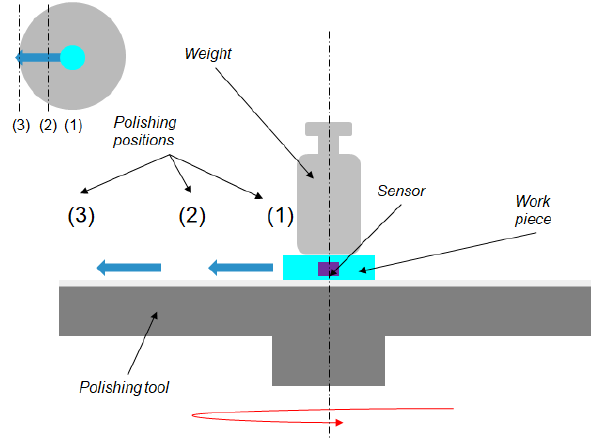
Figure 2: Arrangement of the experiment. The polishing at various points changes the relative speed between tool and workpiece. The weight acts as a force from above on the workpiece equipped with a sensor.